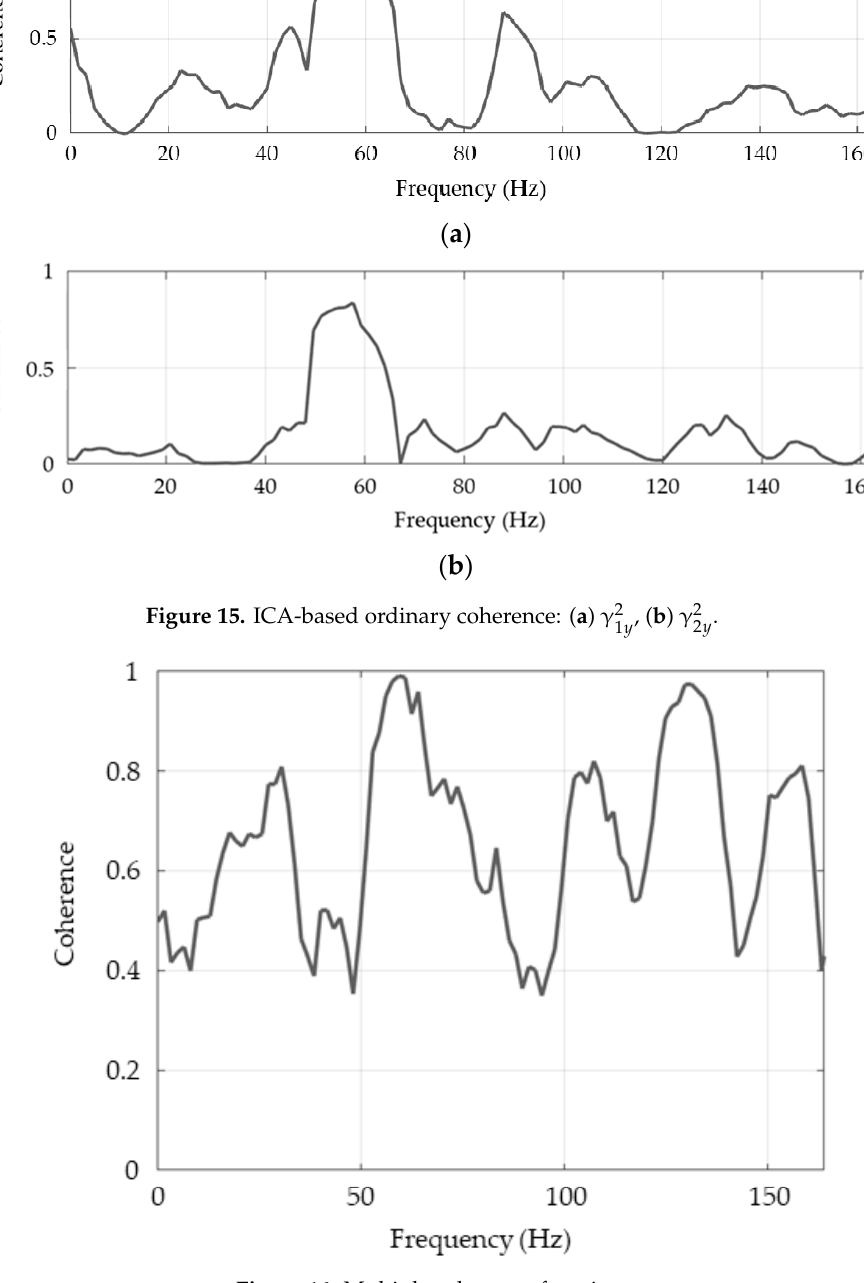
Figure 16. Multiple coherence function.